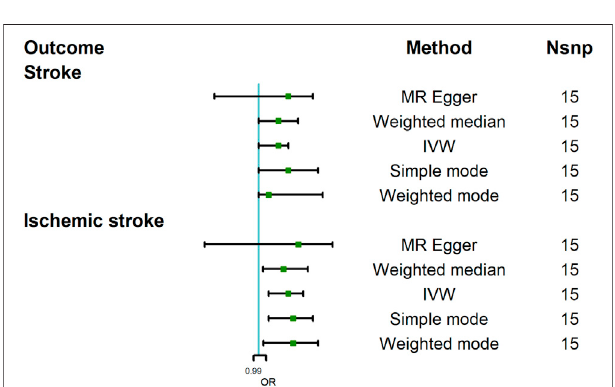
FIGURE 5 | Mendelian randomization analysis results about the causal effects of COVID-19 severity (severe respiratory symptoms due to COVID-19) on stroke and ischemic stroke. CI, credibility interval.